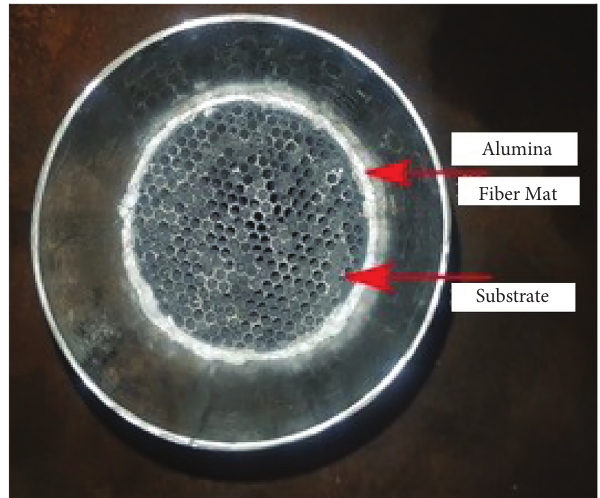
Figure 11: Fabrication images with Alumina support mat.